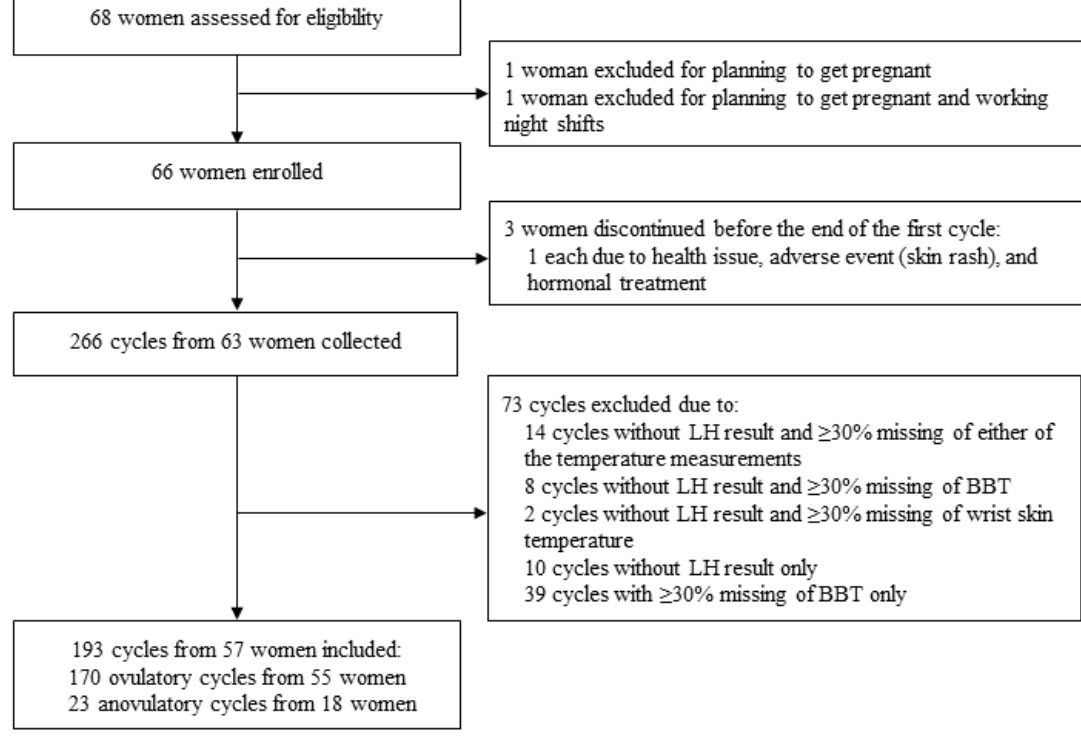
Figure 1. Study flowchart. BBT: basal body temperature; LH: luteinizing